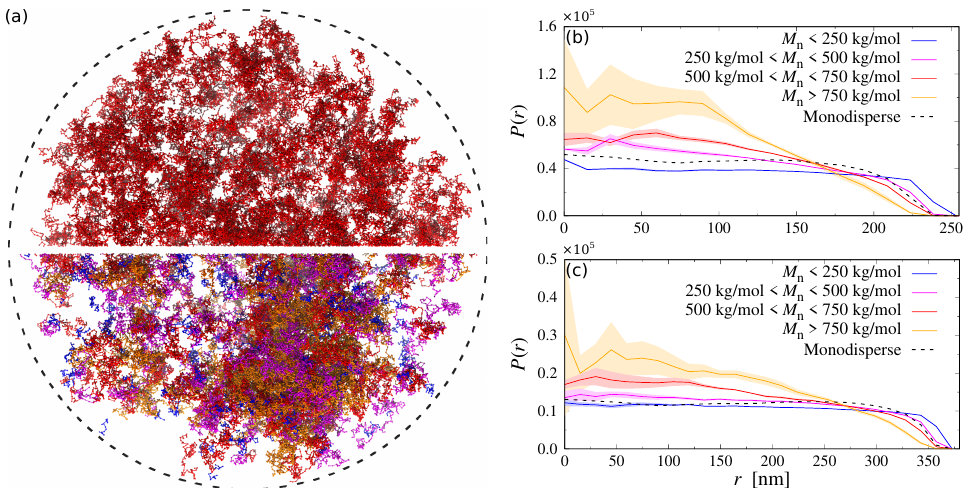
Figure 6. ( a ) Simulation snapshot of the confined systems ( R ≈ 380nm, indicated by dashed circle). The top half shows the monodisperse case with Dextran chains colored in red. The bottom half shows the polydisperse case with Dextran chains colored according to their molecular weight as in panels ( b , c ). Water and PEG particles have been omitted for clarity. ( b , c ) Probability P ( r ) to find a Dextran chain in the specified molecular weight range at center-of-mass position r in a droplet with ( b ) R ≈ 260nm and ( c ) R ≈ 380nm. The shaded area indicates the standard deviation from three independent runs. The dashed black line shows the distribution of the monodisperse case.